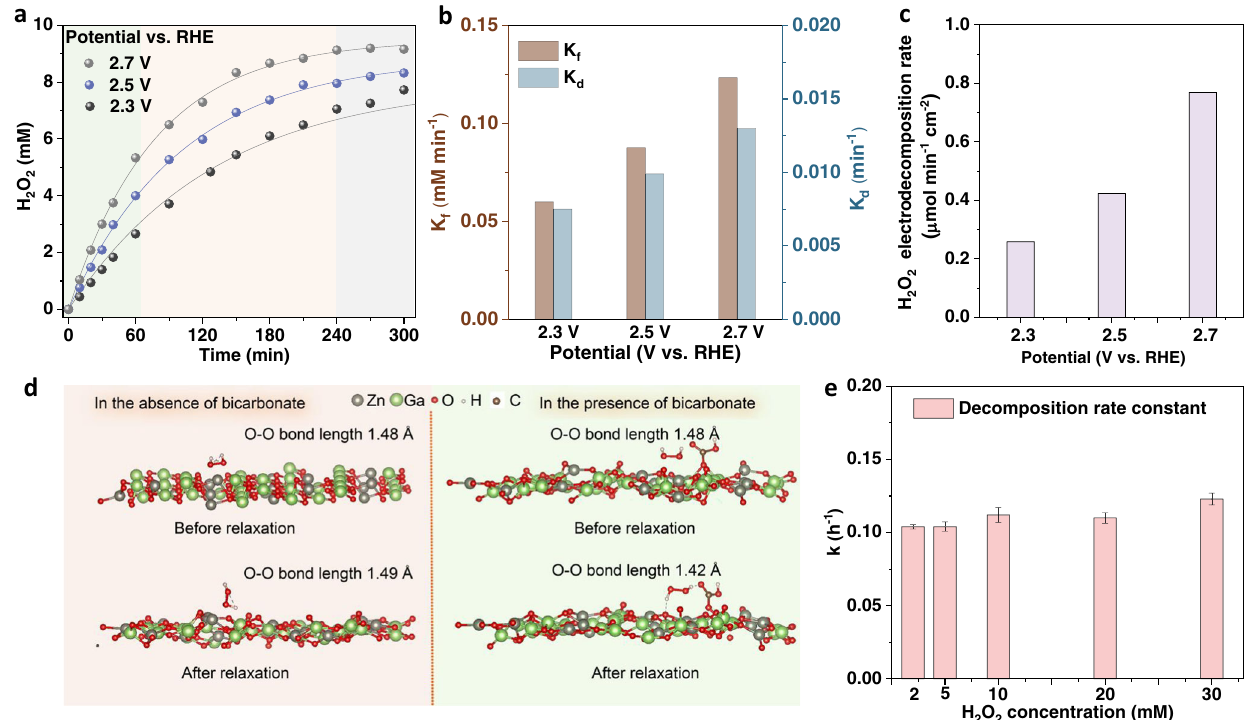
Fig. 3 | The accumulation and decomposition of H 2 O 2 . a The real-time H 2 O 2 concentration as a function of time at 2.3, 2.5, and 2.7V versus RHE. (60mL elec- trolyte, electrode area = 0.5 cm 2 ). The solid lines are the fi tting curves. b The for- mationrateconstantanddecompositionrateconstantofH 2 O 2 onZnGa 2 O 4 anode at different potentials. c Electrodecomposition rate of H 2 O 2 on ZnGa 2 O 4 anode at